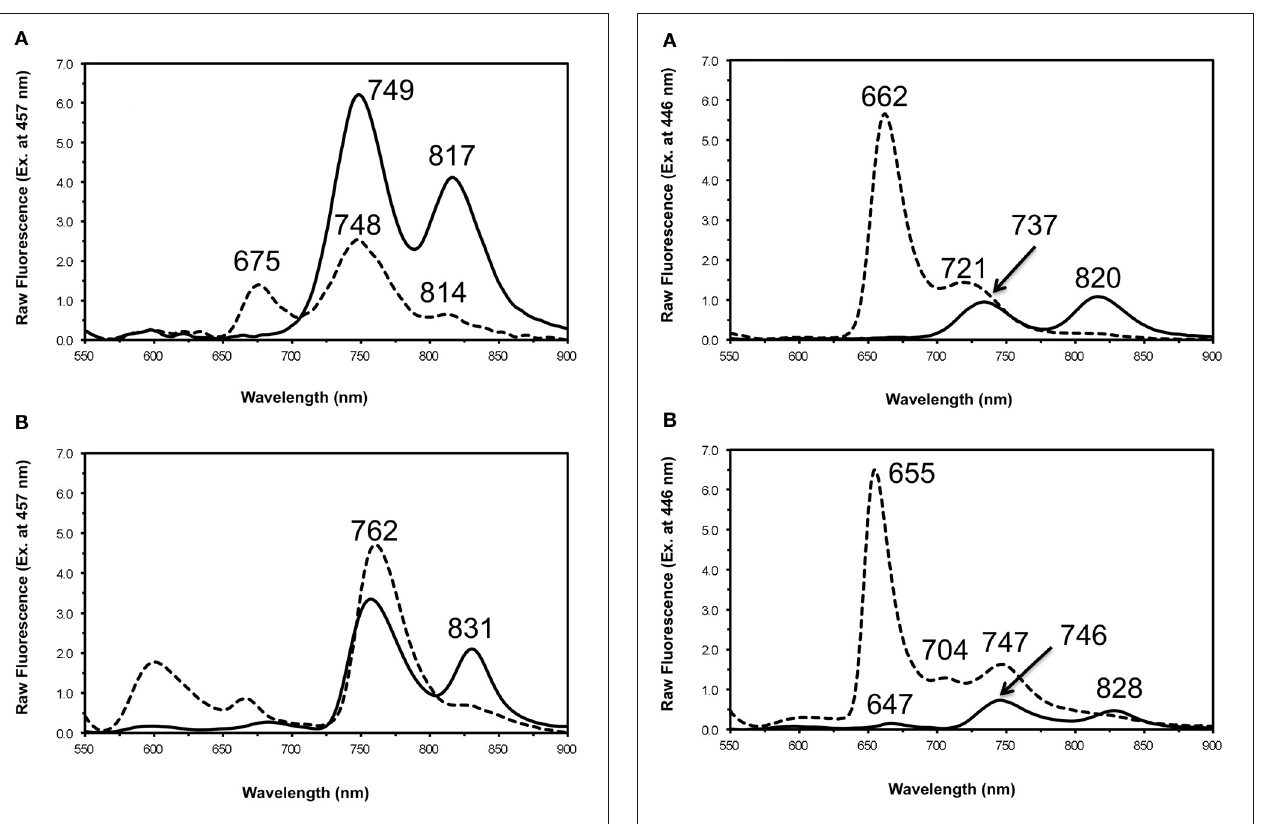
a , 3,8-divinyl Chl a , 3,8-divinyl-Chl b ; and BChl a, b, c, d, e ,